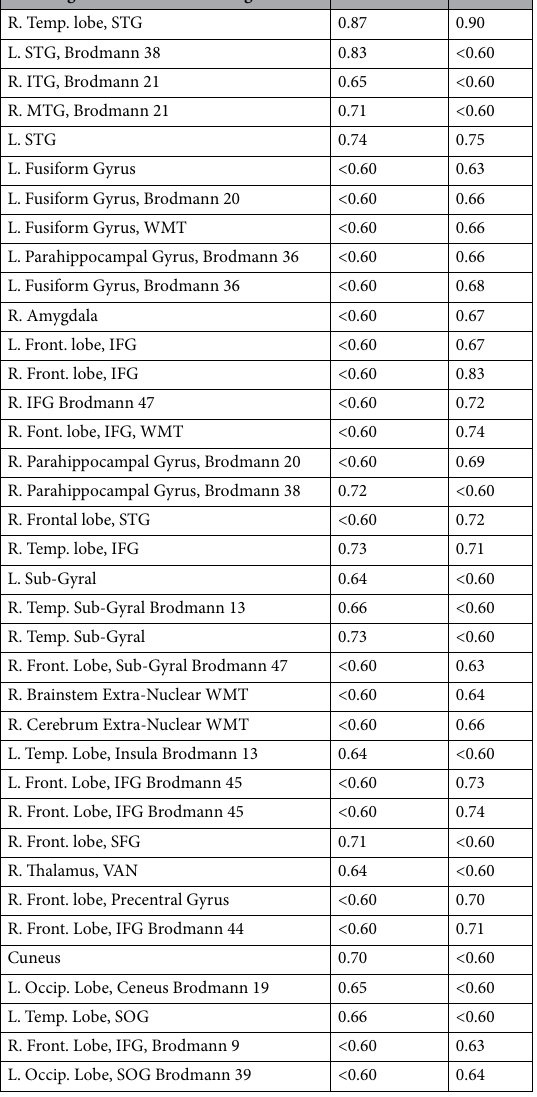
Table 2. Talairach regions most correlated with region #41. These values represent the absolute Pearson correlation between different Talairach regions and region #41 (threshold to above 0.6). Twenty-six regions show a Pearson correlation with region #41 above 0.6 for anxious children, but only 16 for non-anxious children. STG Superior temporal gyrus, ITG Inferior temporal gyrus, MTG Medial temporal gyrus,